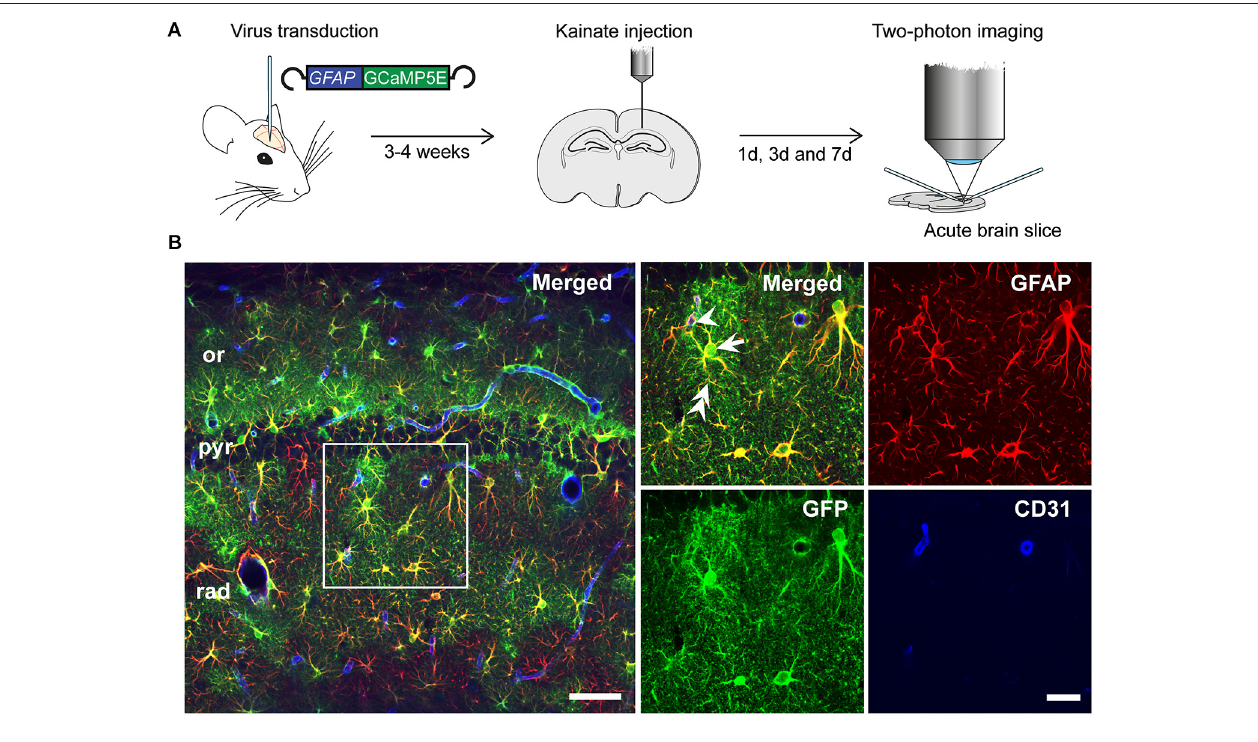
expression in GFAP immunopositive (red) astrocytes. The vascular endothelium was labeled with CD31 antibodies (blue). Arrow: astrocyte soma, double arrow: astrocyte process, arrowhead: endfoot. or, stratum oriens ; pyr, stratum pyramidale ; rad, stratum radiatum . Scale bars, 50 µ m and 20 µ m (boxed motif expanded in